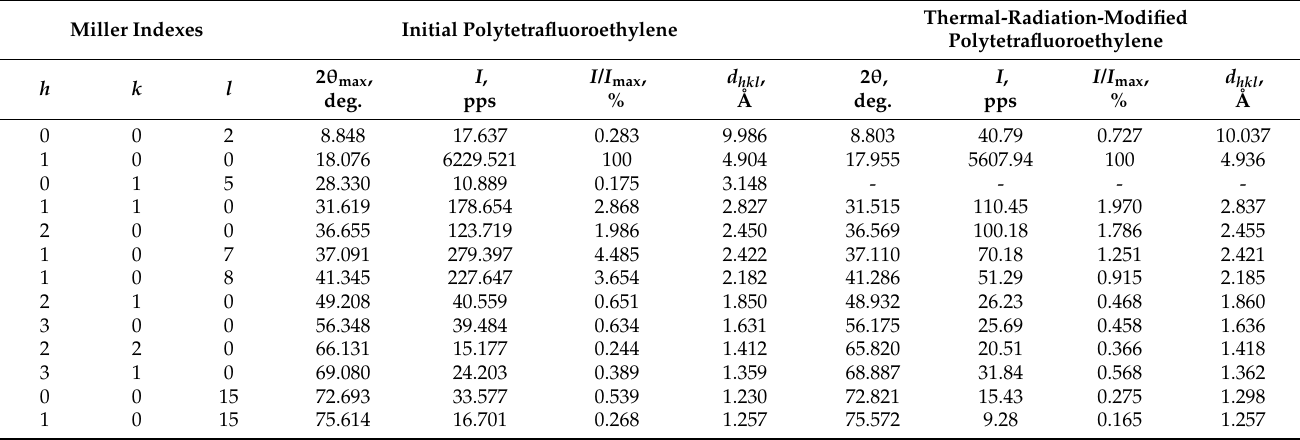
Table 1. Characteristics of the X-ray scattering spectra of the initial and thermal-radiation-modified polytetrafluoroethylene samples. Miller Indexes Initial Polytetrafluoroethylene